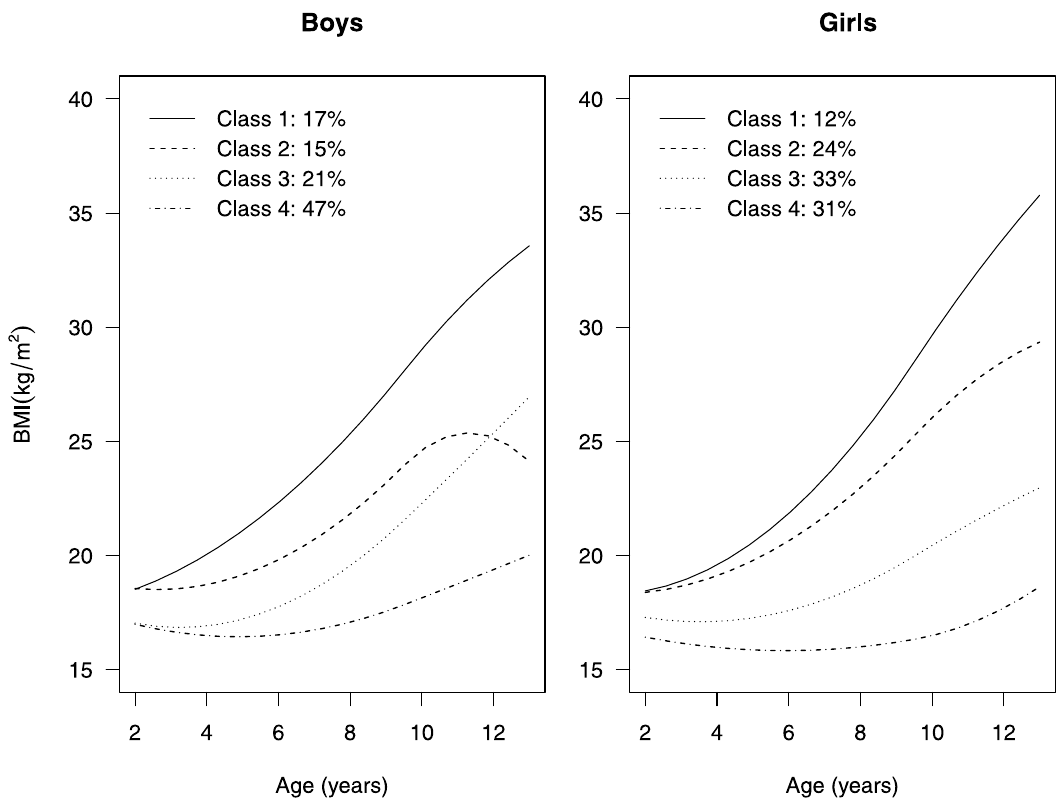
Fig 2. Group-based mean growth trajectories. Estimated group means for boys and girls from four-group growth mixture model fit to the CHAMACOS data.